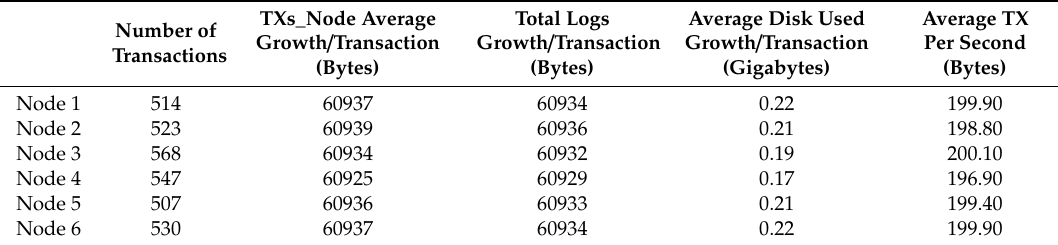
Table 3. Evaluation results.